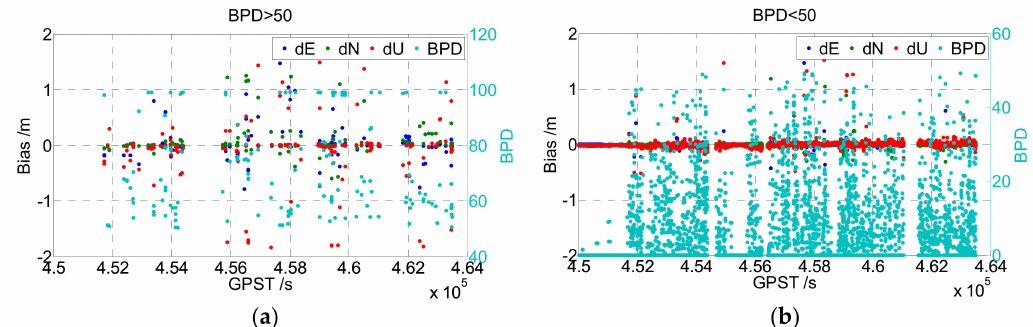
Figure 4. Baseline bias obtained with BPD > 50 ( a ) and BPD < 50 ( b ).